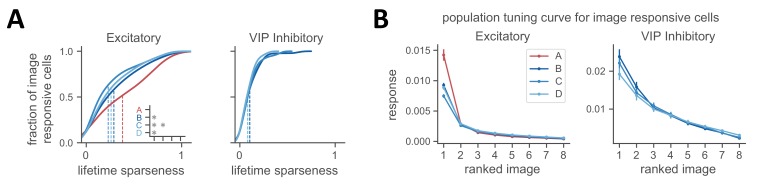
Response sparseness for familiar and novel images.(A) Cumulative distribution of lifetime sparseness values for cells meeting the criteria for image responsiveness described in Figure 3D. Equation for lifetime sparseness is described in Materials and methods. Briefly, this value indicates whether a cell is highly selective in its response across images (value = 1), or whether it responds equally across images (value = 0). For excitatory cells, inset shows comparisons where p<0.008 (statistics described in Materials and methods). For VIP cells, no cells met the criteria for image responsiveness to the familiar image set A, and there were no significant differences across novel image sets. (B) Population tuning curves averaged across all cells meeting the criteria for image responsiveness. Each cell’s response across images within an image set was rank sorted, then averaged. The excitatory population of image responsive cells shows an enhanced response to the preferred image. No image responsive cells for the familiar image set were present in the VIP inhibitory population, so no tuning curve for image set A is shown.